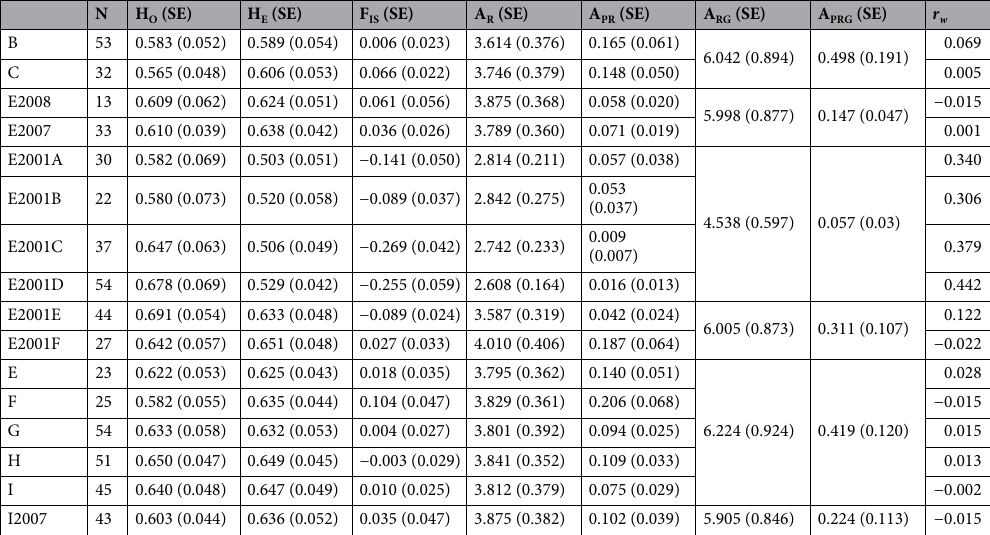
Table 1. Genetic summary statistics of river zones and temporal samples. N number of individuals, H O (SE) observed heterozygosity with standard error, H E (SE) expected heterozygosity with standard error, F IS (SE) inbreeding coefficients with standard error, A R allelic richness, A PR private allelic richness, A RG allelic richness per group, A PRG private allelic richness per group. Standard errors (SE) are given in parentheses. Finally, relatedness estimates per group ( r w ), based on the Wang estimator, are